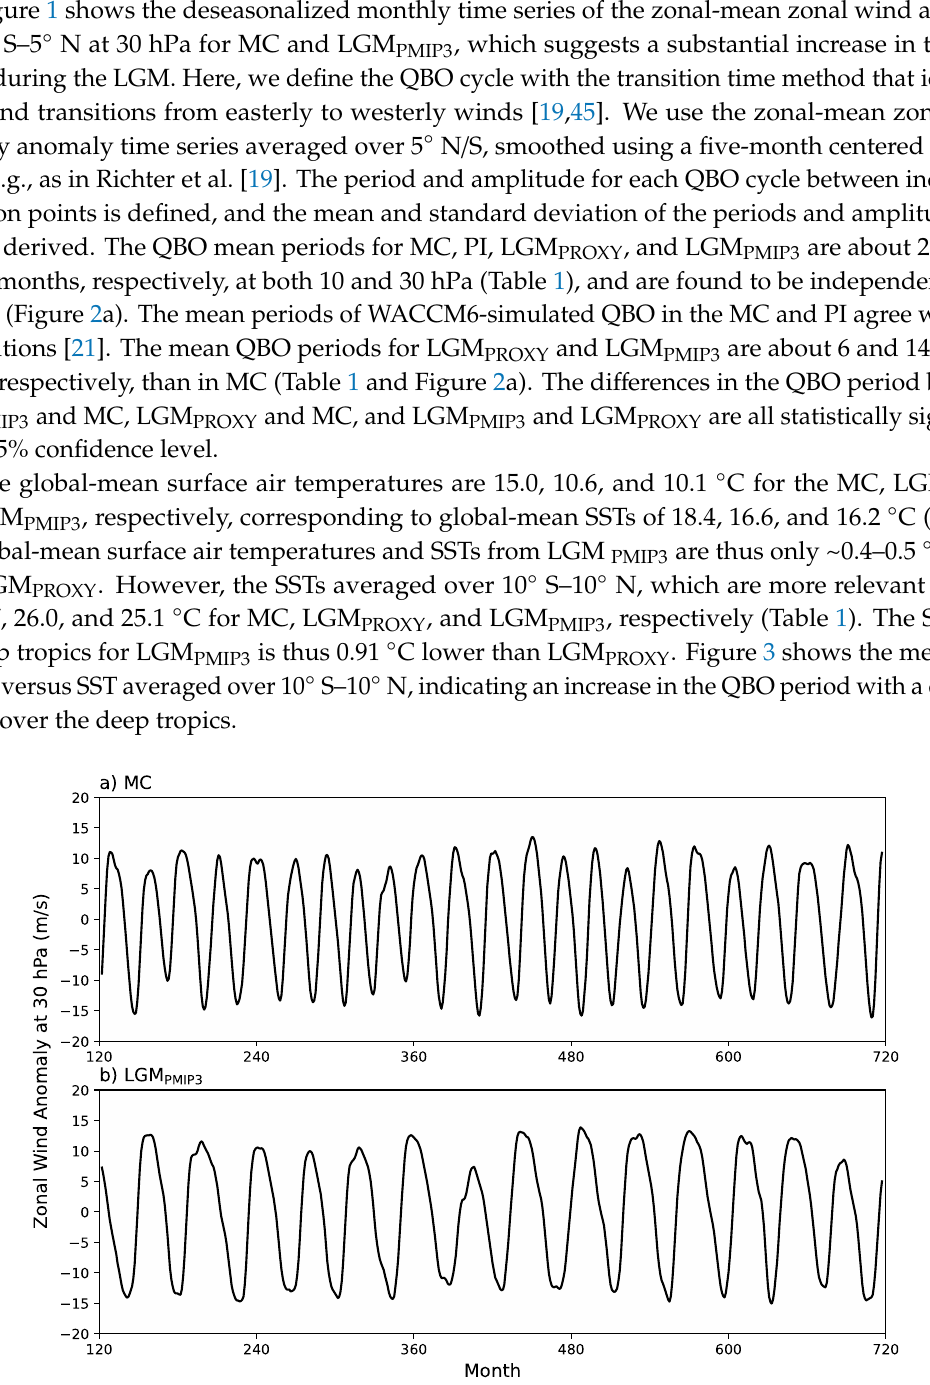
Figure 1. Time series of the zonal-mean zonal wind monthly anomaly averaged over 5° N/S at 30 hPa smoothed with 5-month running mean for the simulations of ( a ) modern climate (MC) and ( b ) Last Glacial Maximum with the PMIP3-simulated sea surface temperature (SST) (LGM PMIP3 ).